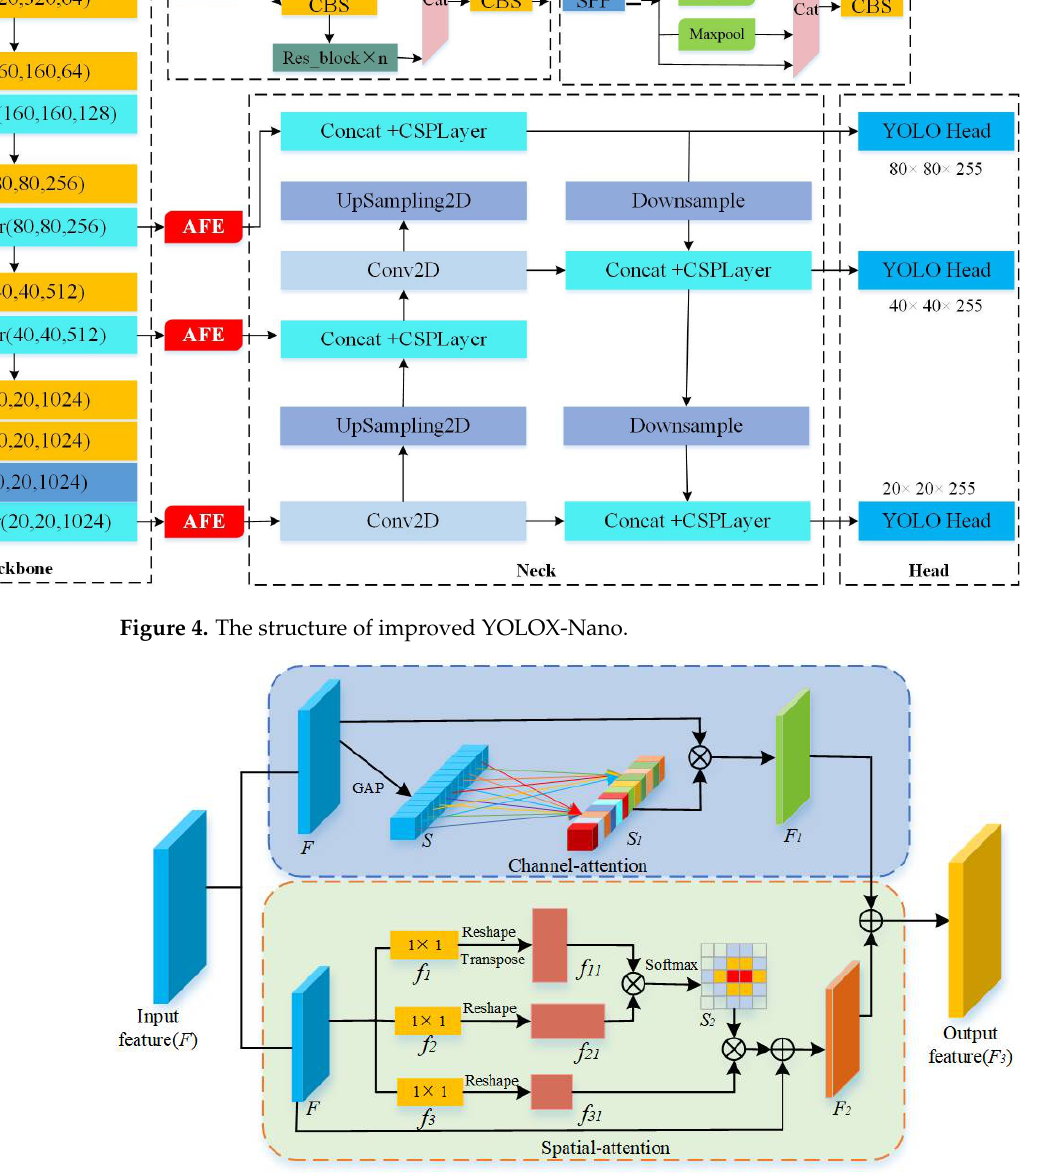
Figure 5. The architecture of attention feature enhancement module.